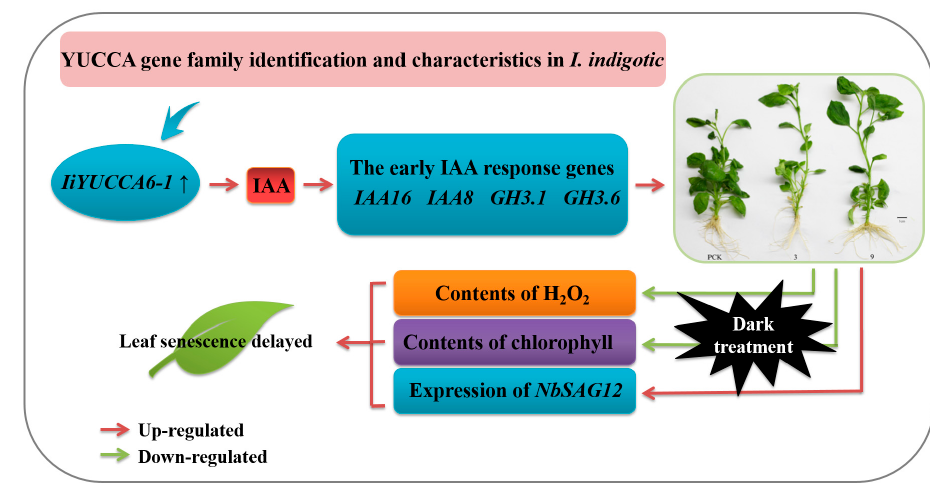
Figure 9. A model of IiYUCCA6-1 -regulated IAA accumulation and leaf senescence.